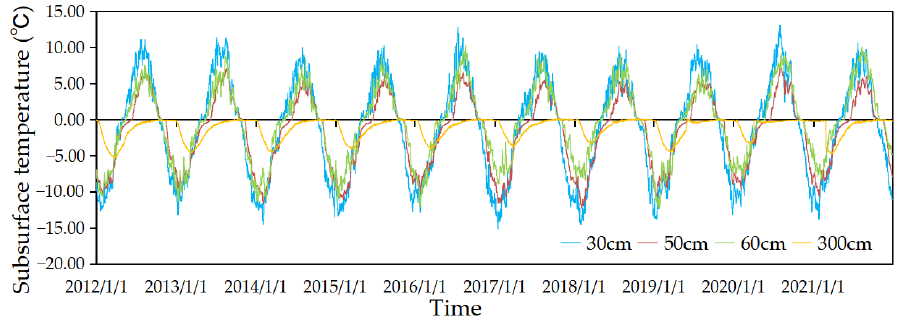
Figure 15. Daily mean subsurface temperatures among 27 CMDC stations at 30, 50, 60, and 300 cm depths for the period from 2012 to 2021.